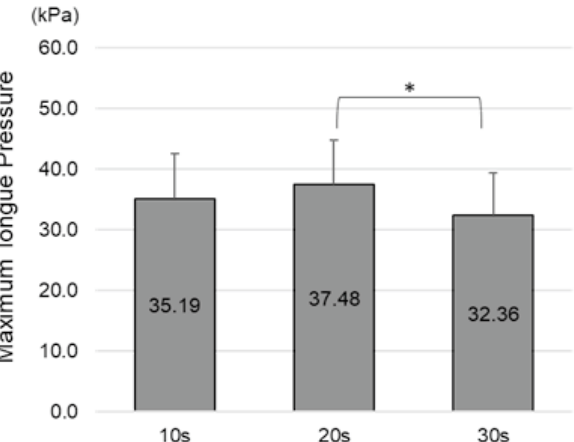
Figure 4. Average MTP among three age groups. * p <0.05